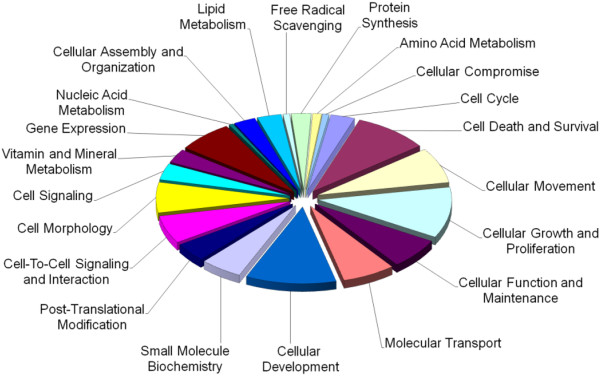
Molecular and cellular functions associated with mTOR-regulated genes differentially expressed in the frontal lobe of mild AD patients. Molecular and cellular functions associated with genes differentially expressed in the frontal lobe of mild AD patients (limbic stage) compared to controls (112 genes). The chart shows the number of genes, expressed as a percentage of the total number, involved in each of the molecular and cellular functions deemed significant by IPA Ingenuity.